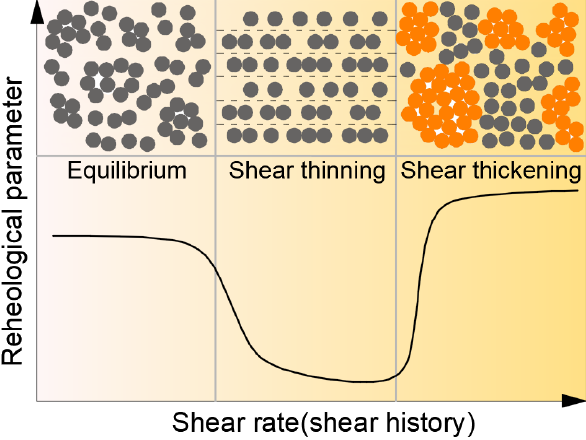
Figure 15: The change in the microstructure of CPB explains the transition to shear thinning and shear thickening. Figure based on Ref.